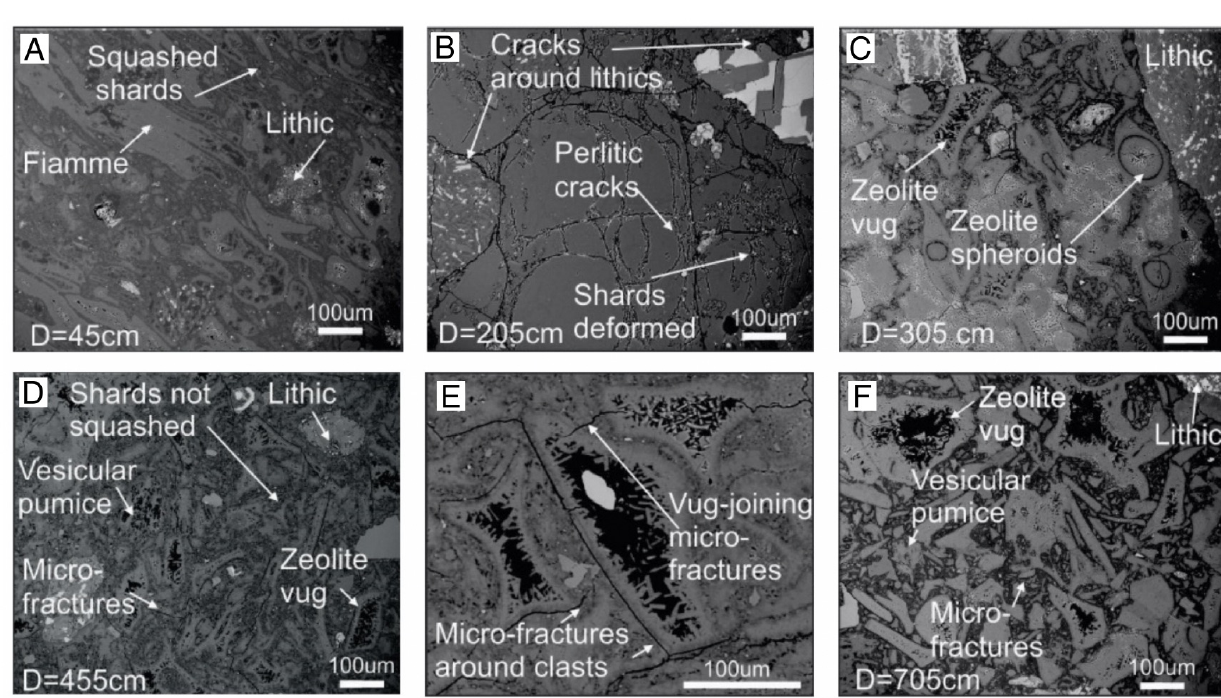
Figure 5: Scanning electron microscope (SEM) textures showing a transition from dense and glass-dominated ignimbrite close to the dyke to the zeolite and vug-dominated ignimbrite greater than 3 m from the dyke margin. [A] Dark welded ignimbrite (VK6), [B] perlitised dark ignimbrite (VK4), [C] blue ignimbrite (VK2). Images [D] and [E] are both the beige country rock ignimbrite from 455 cm from the dyke margin (VK3) shown at different magnifications. Image [F] is the also the beige country rock ignimbrite, but at 705 cm from the dyke margin (VK5).